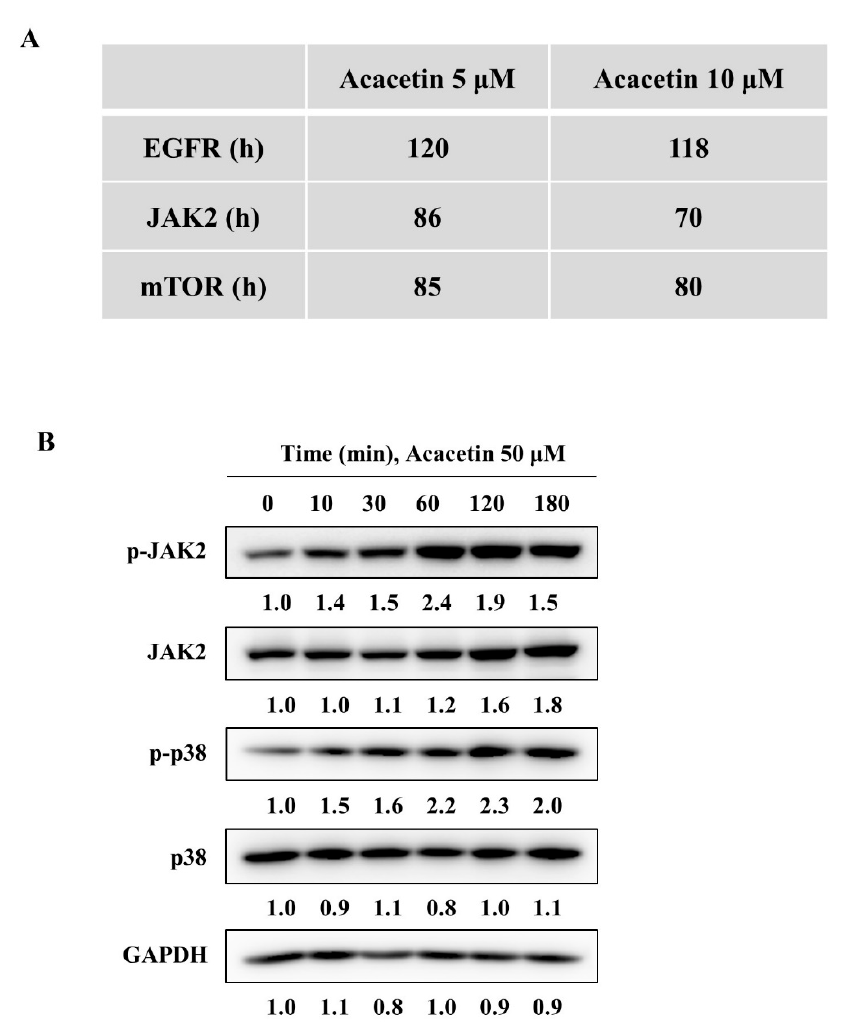
Figure 4. Acacetin does not inhibit STAT3 kinases. ( A ) In vitro kinase assay of known STAT3 kinases in the presence of 5 µ M or 10 µ M acacetin. ( B ) DU145 cells were treated with acacetin (50 µ M) for the indicated time and analyzed by Western blotting with p-JAK2, JAK2, p-p38, and p38 antibodies. The band intensity of each protein was quantified using the MultiGauge program.